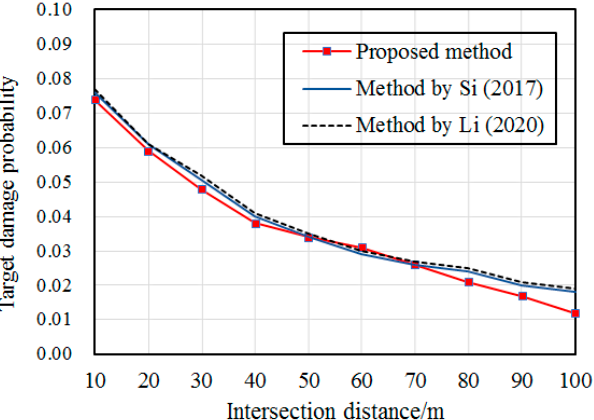
Figure 8. Change curve of the relationship between target damage probability and intersection distance [11,19] .